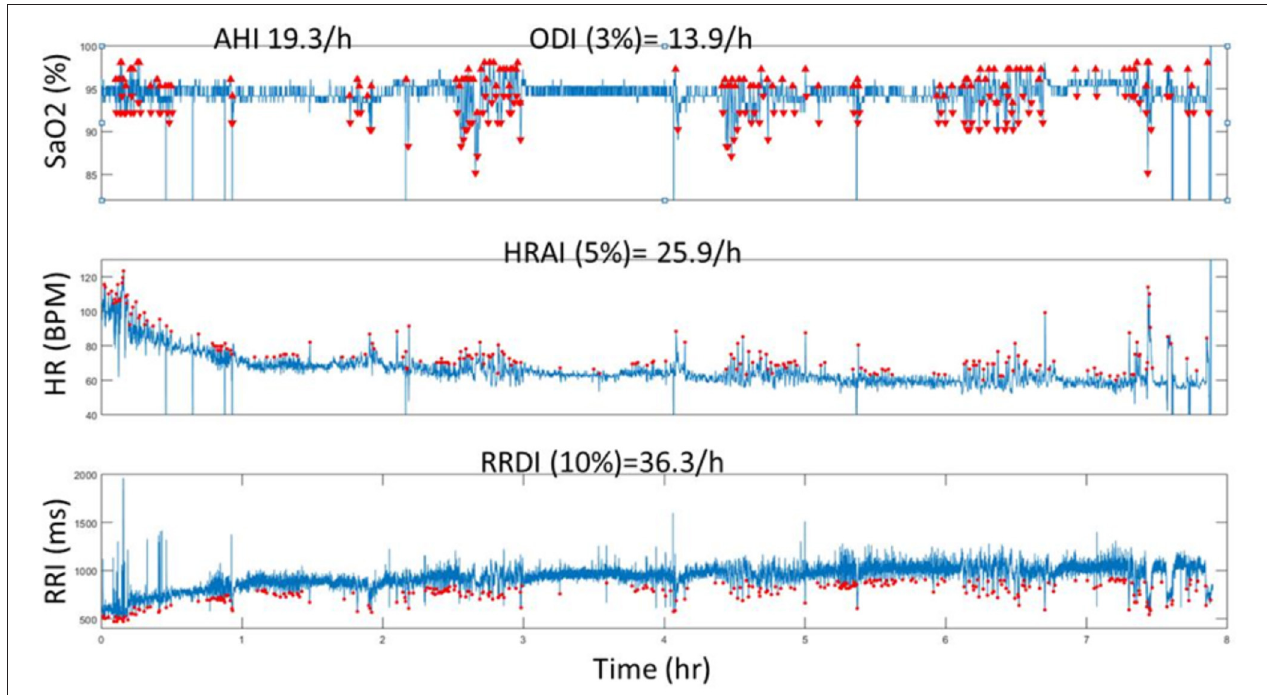
FIGURE 2 | A representative computed data (Tachogram) using automated analysis of SaO2, HR and RRI from one individual who has SDB (AHI = 19.3 events/h). The red dots represent the O2 deasturations, pulse rate accelerations (HR) and RRI dips (from ECG) throughout the duration of the PSG recording (8h). Note the incremental increase of values from ODI, AHI to HRAI and RRDI. HR, heart rate dervied from pulse signal; HRAI, pulse rate acceleration index; RRI, RR interval; RRDI, RRI dips index; SaO2, oxygen